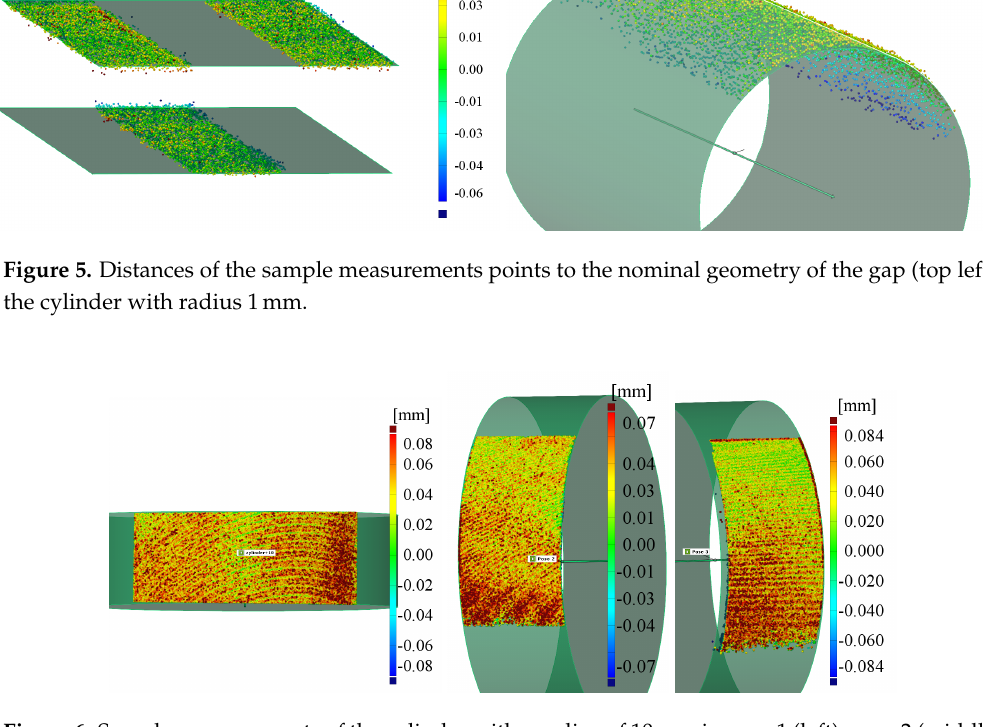
Figure 6. Sample measurements of the cylinder with a radius of 10mm in pose 1 (left), pose 2 (middle) and pose 3 (right).